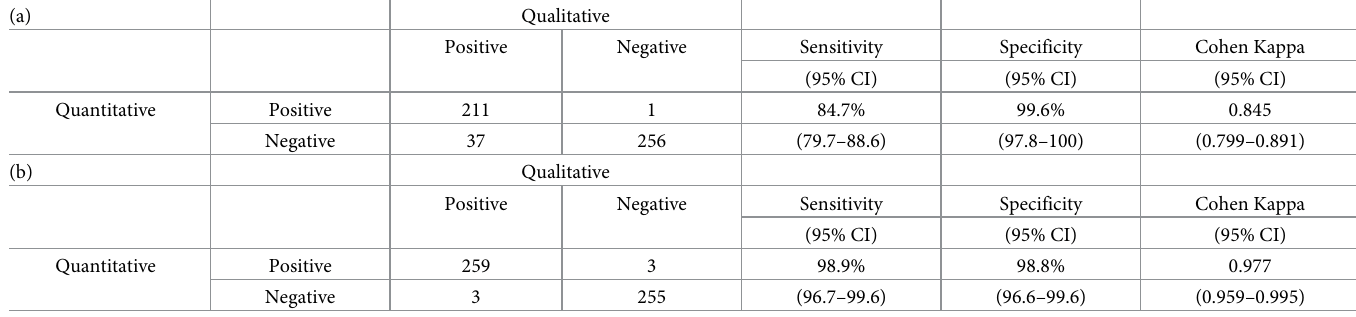
Table 3. (a) Performance of the Roche viral load test using the FVE protocol compared to the Roche qualitative test. (b) Performance of the Roche viral load test using SPEX buffer compared to the Roche qualitative